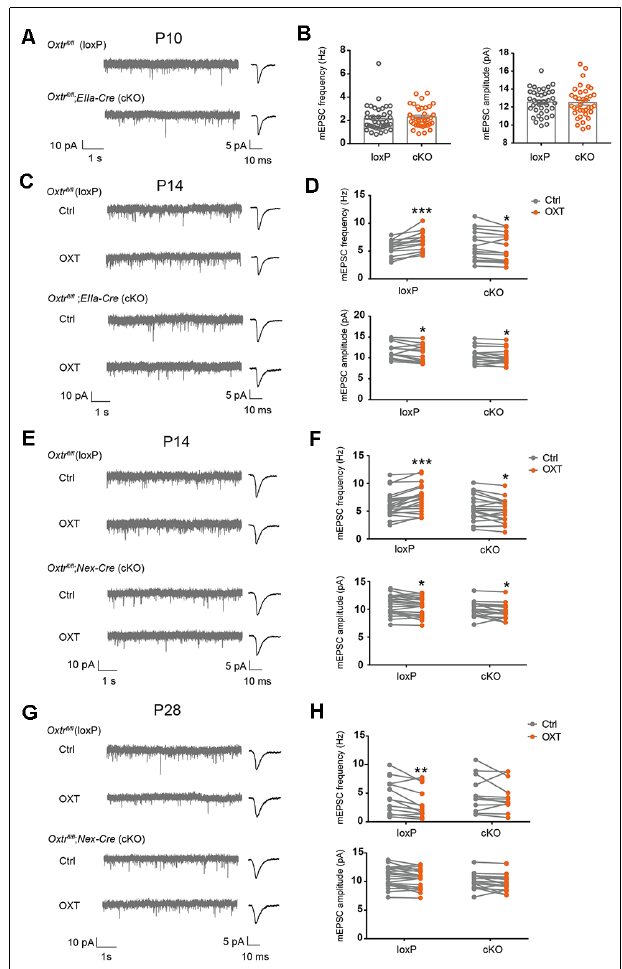
FIGURE 6 | Blockade of oxytocin-induced changes in excitatory synaptic transmission in Oxtr cKO mice. (A) Representative mEPSC recording (left) and average waveforms (right) of P10 EIIa-Cre;Oxtr cKO mice and littermate loxP controls. (B) mEPSC frequency (Ctrl, 2.16 ± 0.18 Hz, n = 38; cKO, 2.30 ± 0.15 Hz, n = 37; P = 0.54, unpaired t- test) and amplitude (Ctrl: 12.55 ± 0.23 pA; cKO, 12.50 ± 0.28 pA; P = 0.90, unpaired t -test) were similar between EIIa-Cre;Oxtr cKO mice and loxP littermates. (C,E,G) Representative mEPSC recordings (left) and average waveforms (right) before (Ctrl) and after (OXT) oxytocin application, age and genotype as indicated. (D) Oxytocin application increased mEPSC frequency but reduced mEPSC amplitude in P14 control mice, while its application reduced both mEPSC frequency and amplitude in P14 EIIa-Cre;Oxtr cKO mice (frequency: loxP, Ctrl, 5.69 ± 0.27 Hz, OXT, 6.78 ± 0.33 Hz, n = 14; P < 0.001, paired t -test; cKO, Ctrl, 5.91 ± 0.48 Hz, OXT, 5.56 ± 0.45 Hz, n = 16; P < 0.05, paired t -test; amplitude: loxP, Ctrl, 11.61 ± 0.37 pA, OXT, 11.0 ± 0.41 pA; P < 0.05, paired t -test; cKO: Ctrl, 10.58 ± 0.34 pA, OXT, 10.24 ± 0.34 pA; P < 0.05, paired t -test). (F) Oxytocin application increased mEPSC frequency, but reduced mEPSC amplitude in P14 loxP mice, while its application